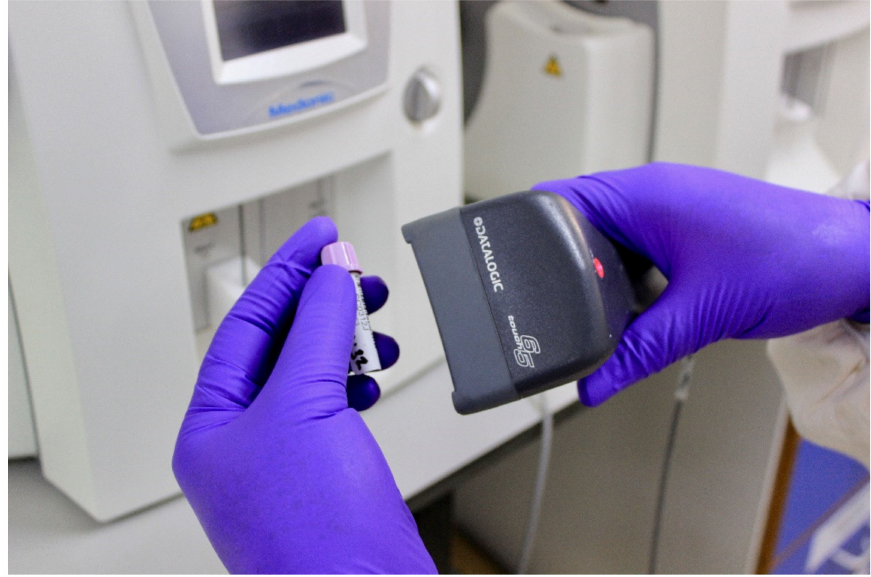
Figure 5. Photograph of sample processing done to Good Clinical Lab Practice